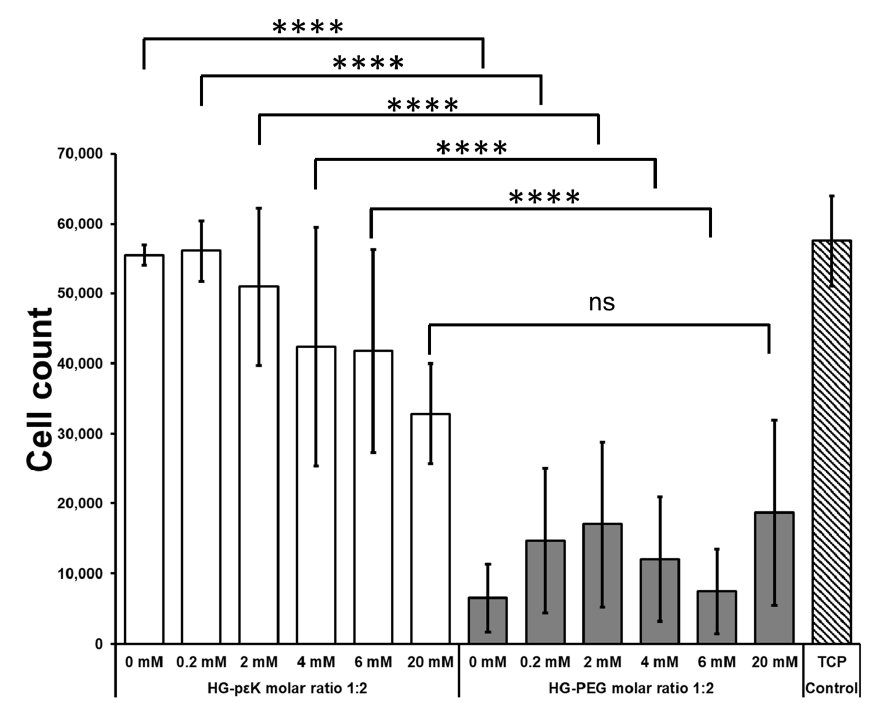
Figure 5. HeLa cell proliferation capability on HG-P ε K and HG-PEG with molar ratios of 1:2 and varying levels of RGD. AlamarBlue metabolic activity assay after 48 h cell incubation (see Figures S3–S5 in Supplementary Materials). Tissue culture plastic (TCP) control experiment corresponds to cells seeded on tissue culture plate. Cell count on hydrogels confirmed live/dead cell viability experiments for the HG-P ε K and HG-PEG gels. Cell number analysis indicated higher cell proliferation rates on HG-P ε K after 48 h compared to cells cultured on the HG-PEG constructs. One-way ANOVA with Bonferroni post-test (ns = no significant * p ≤ 0.05, ** p ≤ 0.01, *** p ≤ 0.001, and **** p ≤ 0.0001). Data